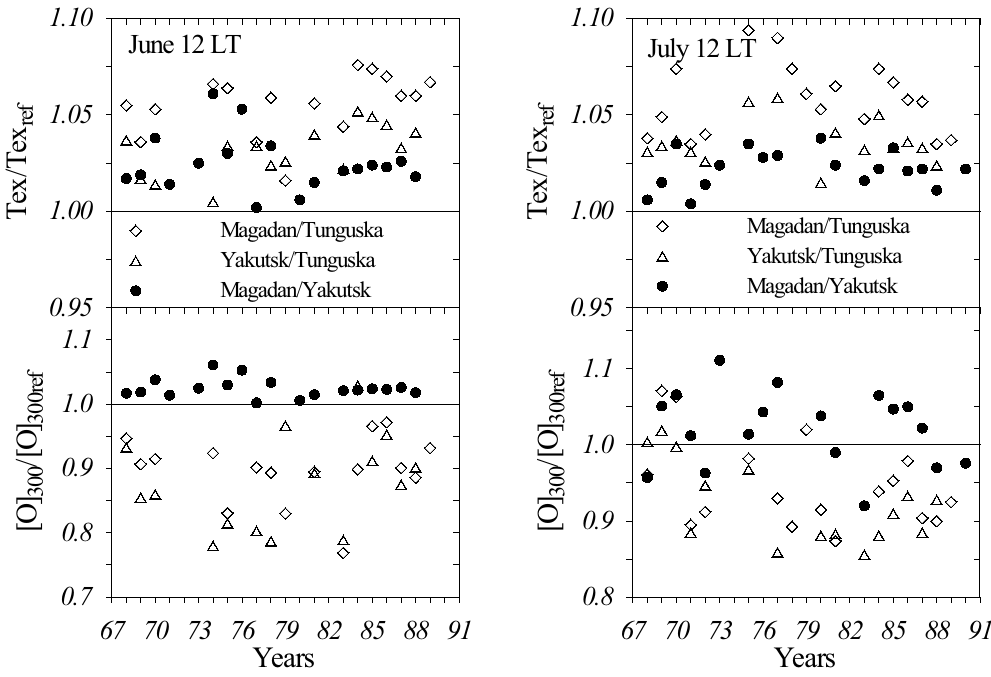
Figure 4. Ratios for exospheric temperature Tex and atomic oxygen [O] at 300 km retrieved at Tunguska, Yakutsk, and Magadan stations for June and July at 12 LT. The subscript ‘ref’ is referred to a station standing in the denominator.